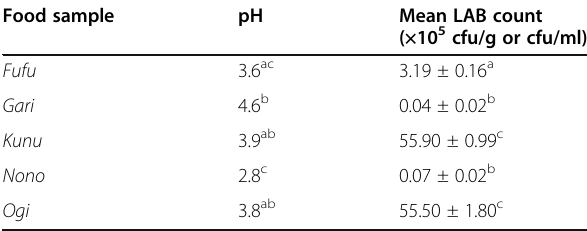
Table 1 pH values and total viable LAB counts (cfu/ml) of fermented food samples